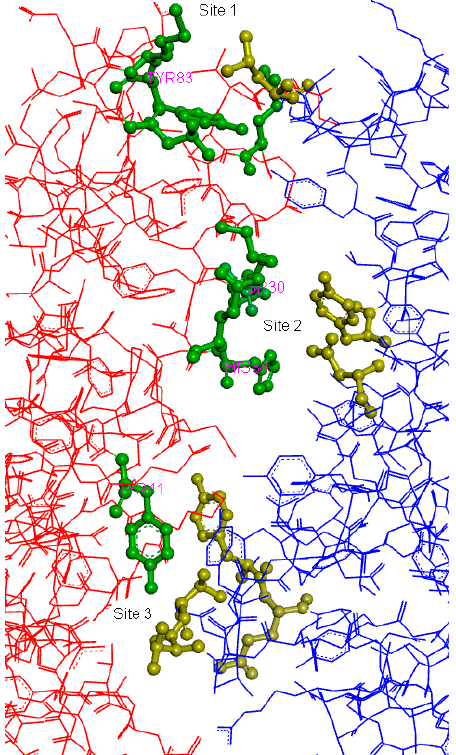
Figure 7. The three major interacting sites between the ACE2 (red) and nCoV (blue) showing each site docked with the major amino acids involved in the interaction.